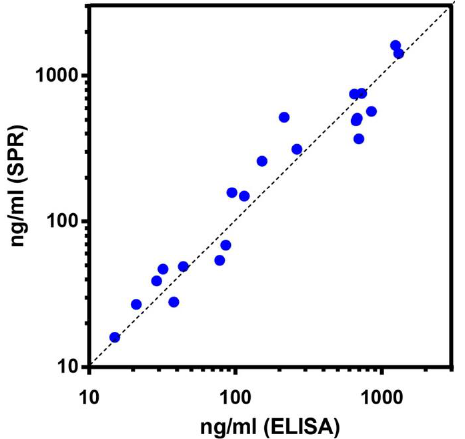
Figure 6. Correlation between plasma PTX3 levels quantified with the new SPR-based immunoassay and the traditional ELISA assay. Each point represents a single